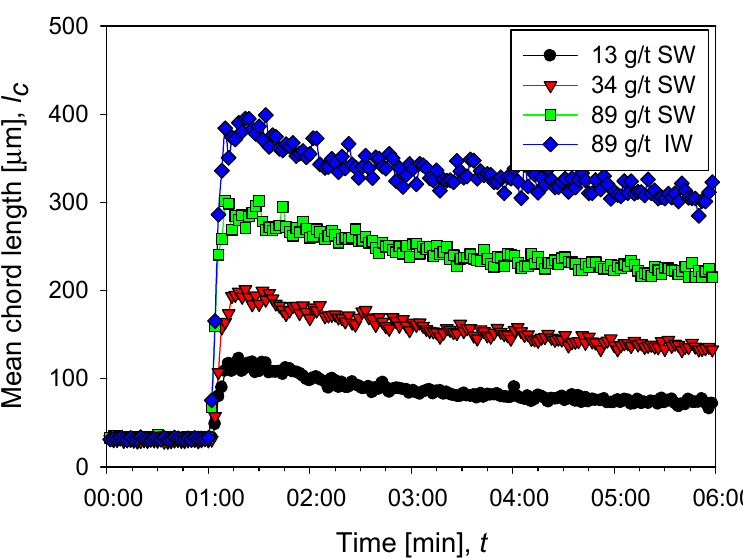
Figure 2. Evolution of the average size of aggregates of kaolin particles (chord length) before and after the addition of flocculant in different doses in seawater (SW) and industrial water (IW).